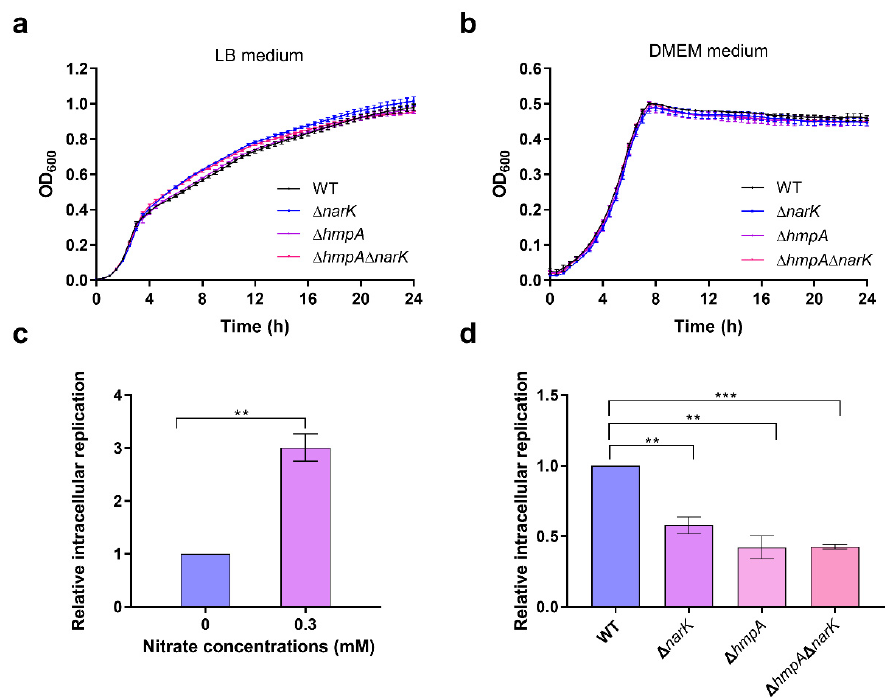
Figure 2. Nitrate utilization promotes S. Typhimurium replication in macrophages. ( a , b ) Growth curves for S. Typhimurium WT, Δ narK, Δ hmpA , and Δ hmpA Δ narK in LB medium ( a ) and